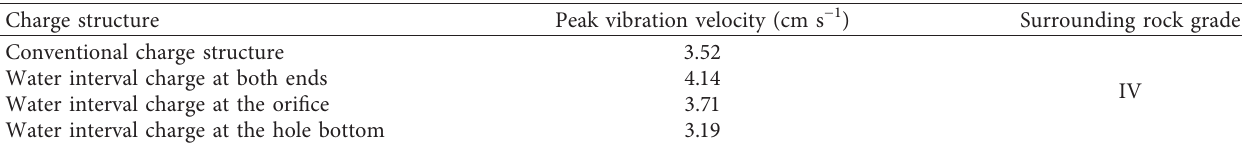
Figure 7: Comparison of original and denoised signals. (a) Conventional charge structure. (b) Water interval charge at both ends. (c) Water interval charge at the orifice. (d) Water interval charge at the hole bottom. Table 3: Peak vibration velocity of different charge